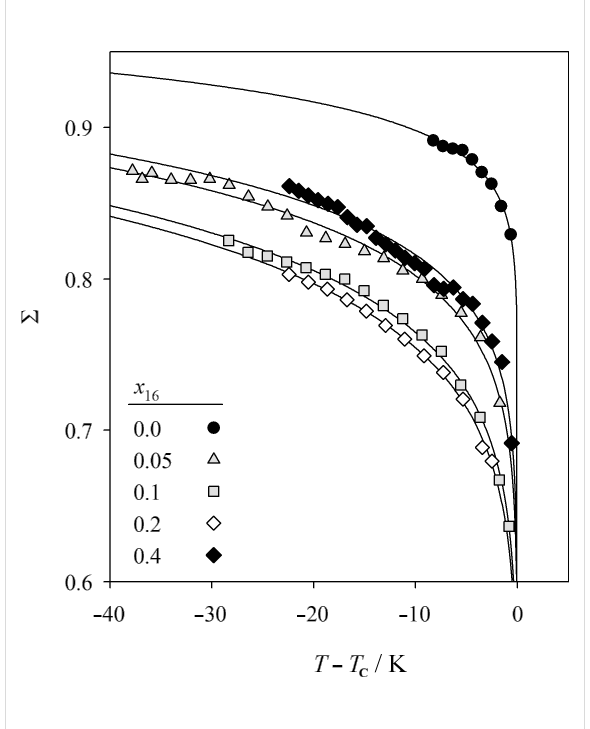
Figure 7: Translational order parameter Σ in the SmA phase versus temperature difference to the phase-transition temperature T − T c for the mixtures with x 16 = 0.4 (filled diamonds), 0.2 (open diamonds), 0.1 (grey squares) and 0.05 (grey triangles) and for the pure compound 2PhP (filled